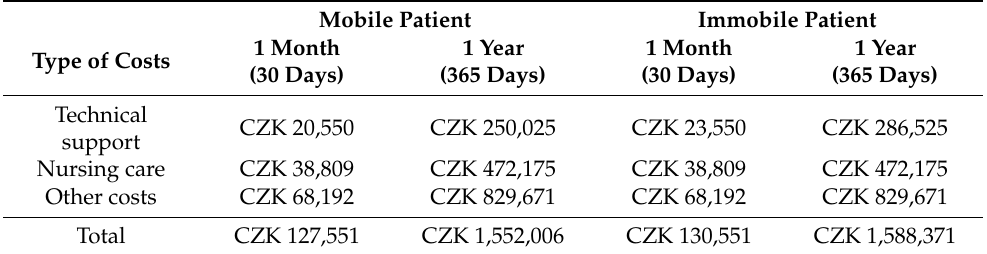
Table 3. The overall costs per patient with invasive home mechanical ventilation for the year 2020.